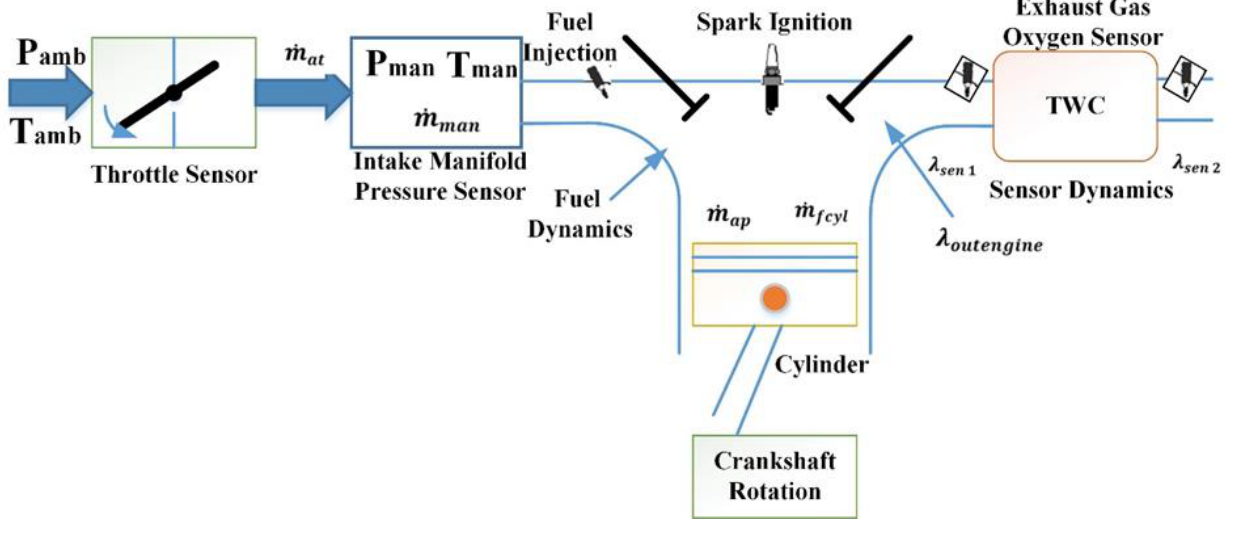
Figure 2. AFR system with Sensor Marking [16].